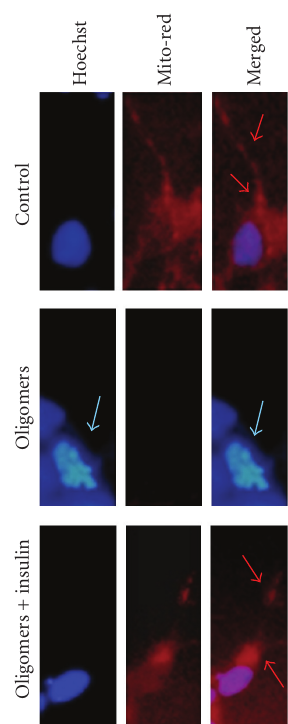
Figure 4: Insulin recovers mitochondrial respiratory activity, reduced by rA β 42 oligomers. LAN5 were untreated (control), treated with rA β 42 oligomers (40 μ M) for 1 h (oligomers), rA β 42 oligomers (40 μ M) for 1 h and insulin (100 μ M) for 20 h (oligomers + insulin). Cells were incubated with Mito Red and Hoechst 33258. The images of each sample were merged. Red staining indicates mitochondrial activity (see red arrows). Blue staining indicates nuclear fragmentation (see blue